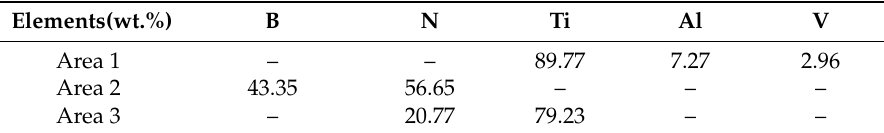
Table 2. Elemental concentration of the selected areas of the cBN / Ti6Al4V